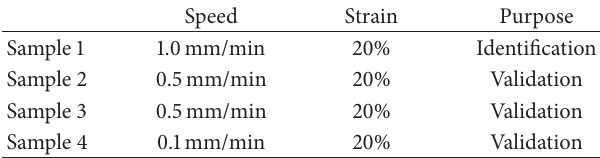
Table 1: Experimental conditions of the cyclic